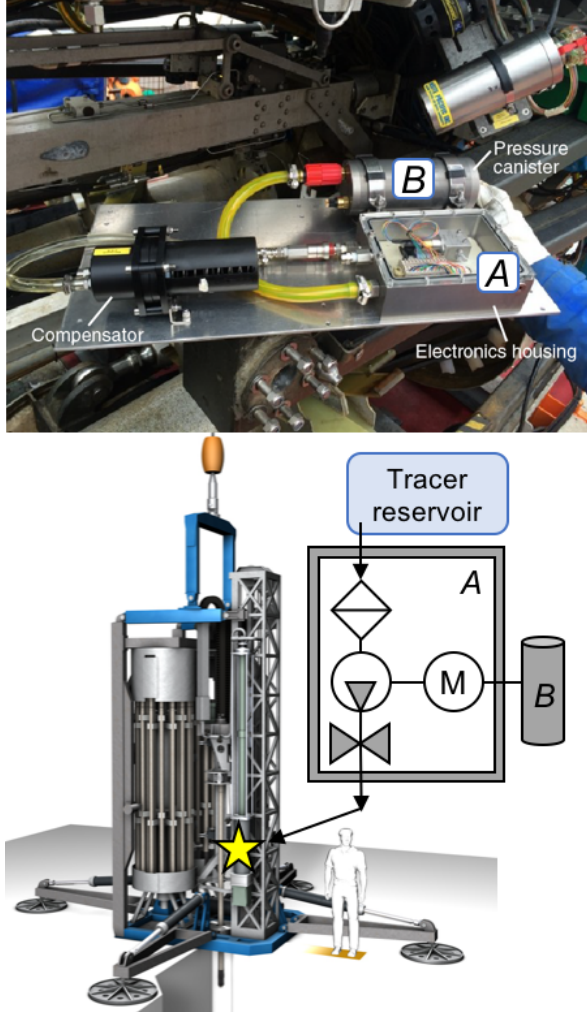
Figure 1. The drill-mounted tracer injection system during IODP Expedition 357. The top panel shows a plate on the MeBo seabed drill with the filter-pump-valve (F-P-V) module (A) in an electron- ics housing, pressure canister with micromotor controller (B), and oil compensator. The lower panel shows a schematic of the tracer system as mounted on the MeBo drill rig. A flexible bag with a tracer was connected to the F-P-V (A), with pumping controlled by the motor (B), to deliver the tracer to the suction and mixing cham- ber (star) for mixing with bottom seawater before being injected into the borehole via a displacement pump. Top panel image courtesy of Tim Freudenthal, and reproduced from Fig. F17 in Früh-Green et al. (2017e) with